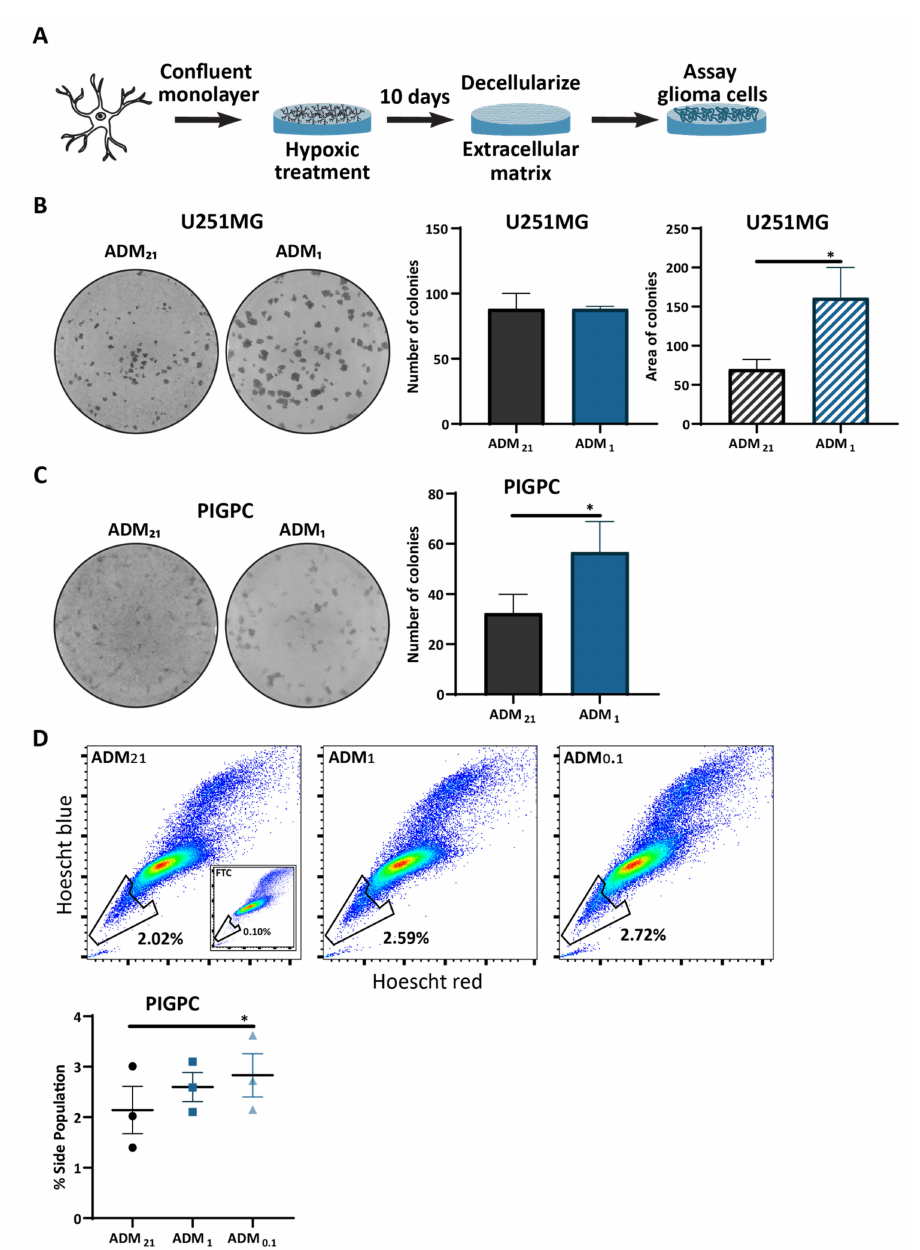
Figure 4. Extracellular matrix from hypoxic astrocytes alters the properties of glioma cells. ( A ) Experimental design. ( B ) Representative images of colony forming ability of U251MG glioma cells plated on clonal density on ADM 21 or ADM 1 in triplicate wells and quantification of colony number and size. * p < 0.05, ratio paired t-test. ( C ) Representative images of the colony forming ability of PIGPC glioma cells plated on clonal density on ADM 21 or ADM 1 in triplicate wells and quantification of colony number. * p < 0.05, ratio paired t-test. ( D ) Side population assay of PIGPC cells cultured on ADM 21 , ADM 1 , or ADM 0.1 . The graph shows quantification across three independent experiments. * p < 0.05, one-way ANOVA (Tukey’s multiple comparisons test). All data represent mean ± SEM. All data represent one replicate from three independent astrocyte